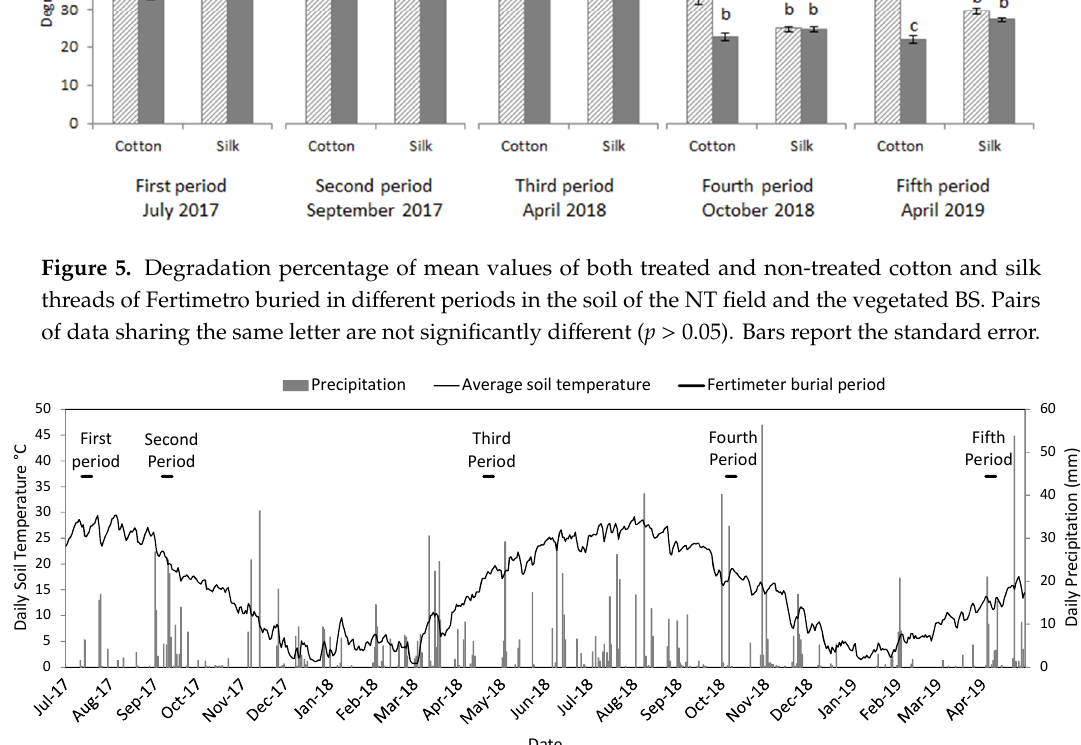
Figure 6. Meteorological data during the trial period with the Fertimetro burial periods indicated. Soil temperature was measured at the depth of 10 cm.